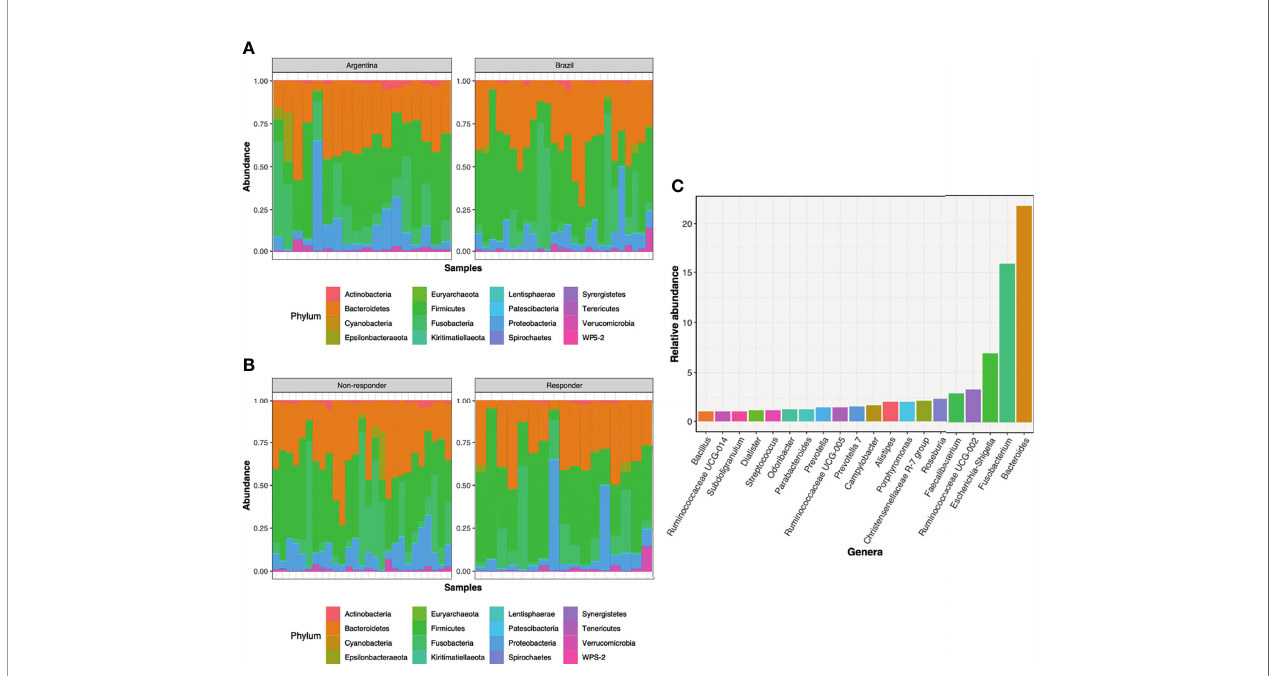
FIGURE 4 | Main bacterial phyla and genera in pre-treatment biopsies of LARC: (A) Relative abundance of the main phyla according to the (A) country of origin of the samples and (B) response to neoadjuvant treatment: R and NR patients. (C) Relative abundance of bacterial genera from Argentina and Brazil, with relative abundance above 1%.